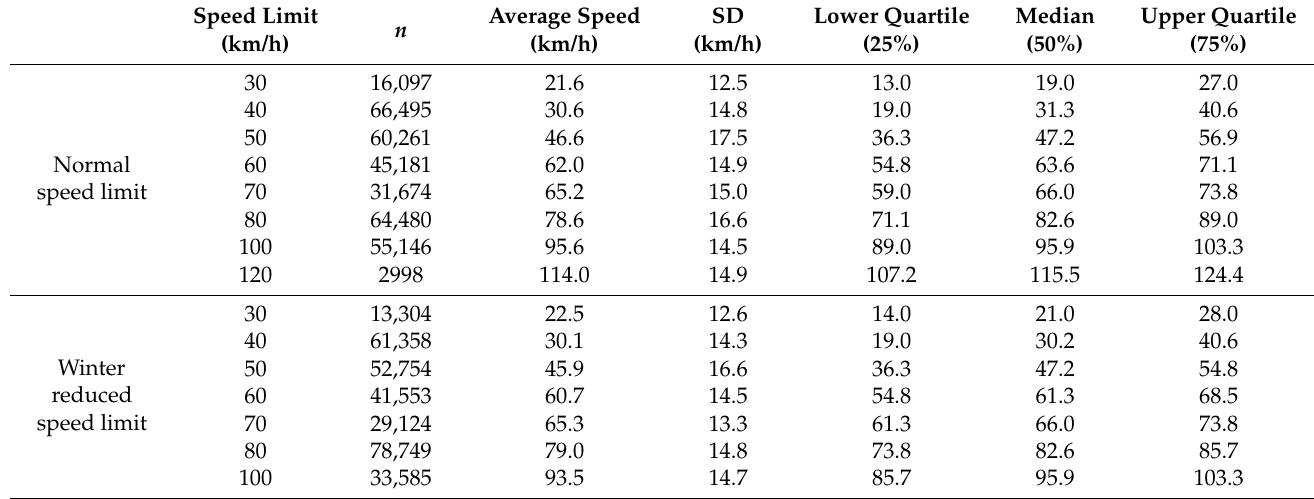
Table 2. Registered driving speeds by road speed limit in non-urgent ambulance D-mission